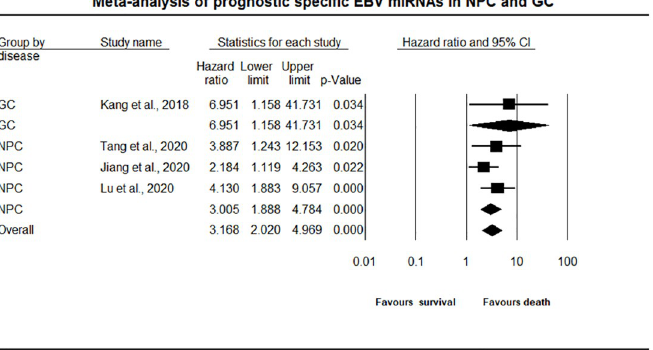
Fig 2. The forest plot of EBV miRNA survival outcomes in NPC and GC patients. CMA software (version 3.3.070, USA) was used to construct and assess the pooled hazard ratios of HR values for NPC and GC prognostic data. The black square with line indicates the estimated pooled effect of survival for NPC and GC patients randomly allocated to EBV miRNA evaluation. The effect size of EBV miRNA in the included studies was represented by a black diamond, with a 95% confidence interval. A HR of one indicates that there is no difference in the risk of NPC or GC patients’ survival. A HR more than one implies an increased risk of patient survival, whereas a HR less than one indicates a lower risk of patient survival.